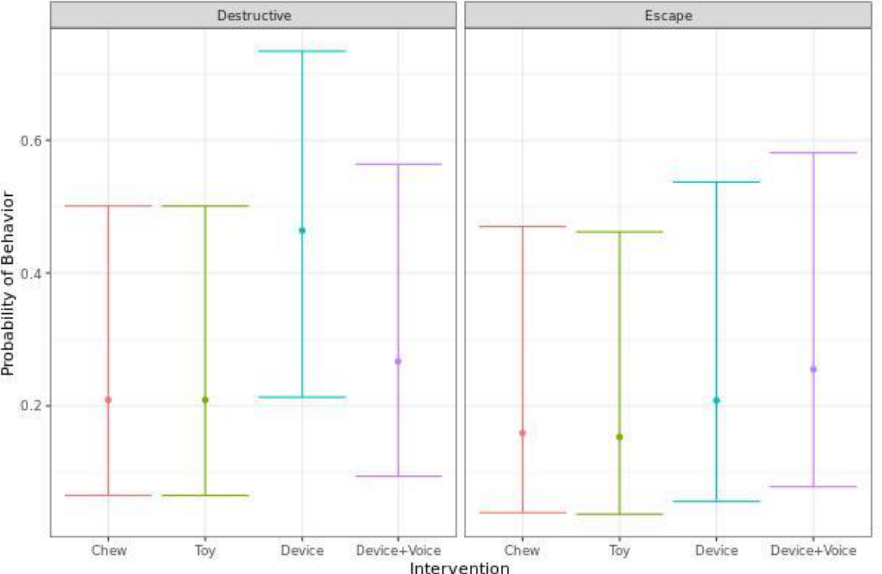
Figure 4. Predicted probability (95% CI) of dogs performing destructive or escape behaviors when they were left alone with one of four enrichments for 20 min. No significant differences between treatments groups were identified( p < 0.05).